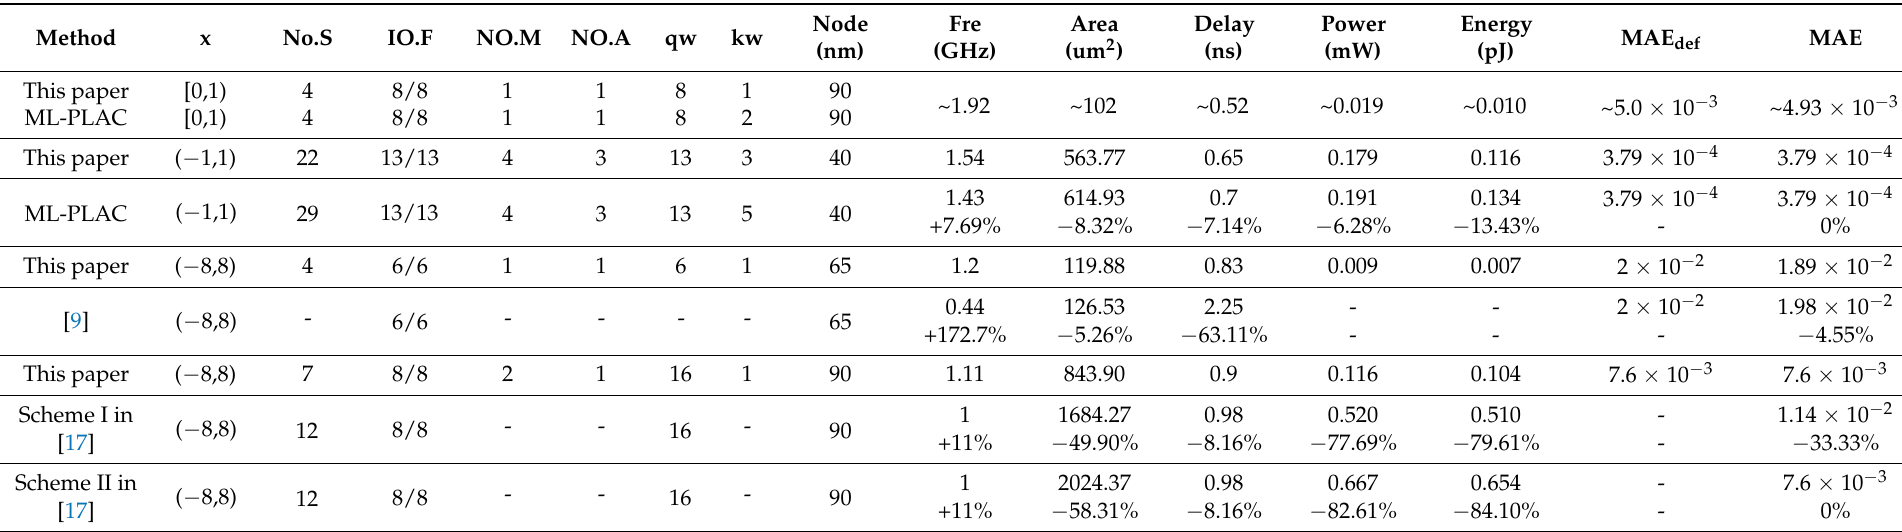
Table 8. Performance comparison for sigmoid ( x )